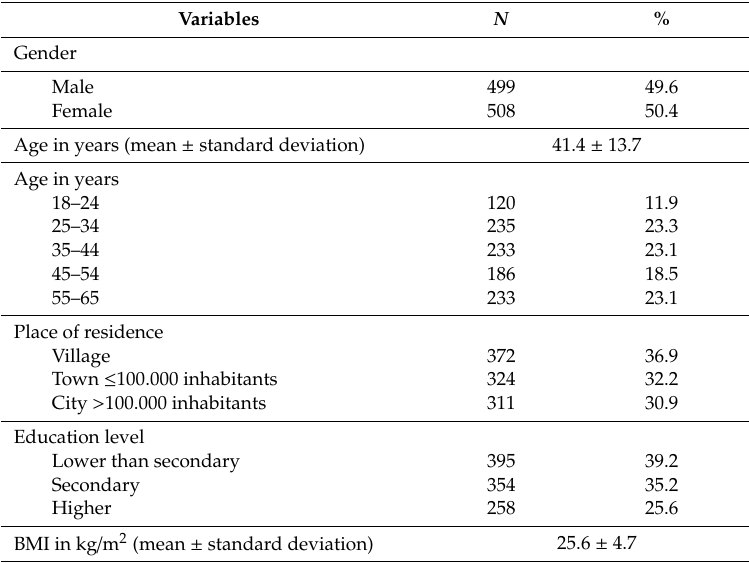
Table 2. Sociodemographic characteristics of the study sample ( N =